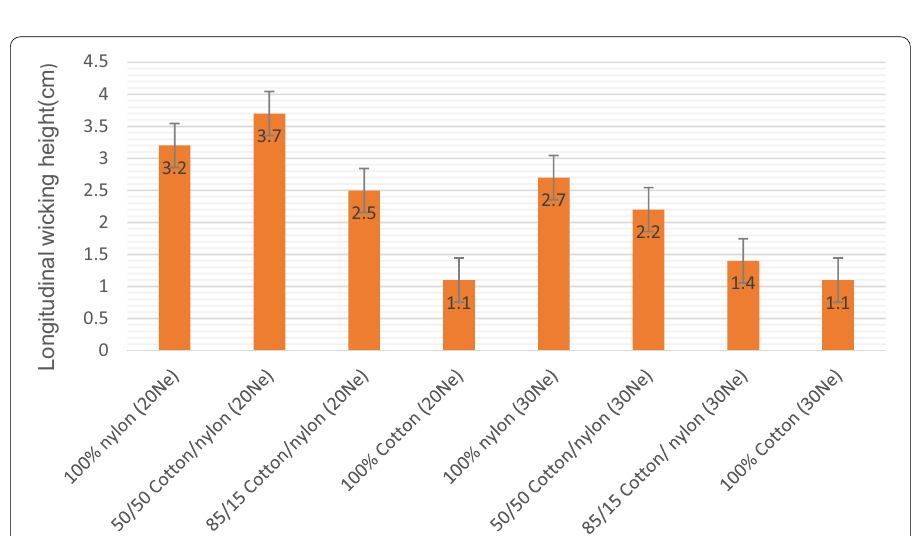
Fig. 3 Woven fabrics Longitudinal wicking